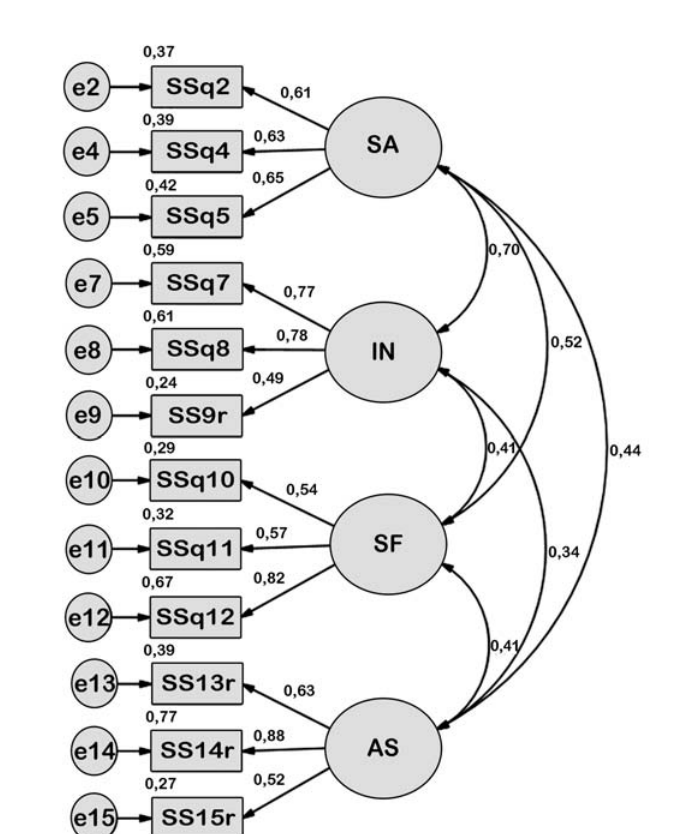
Figura 1 . Pesos fatoriais e con fi abilidade indi- vidual dos itens da ESSS re fi nada e correlações entre fatores na amostra global (Portugal e Bra- sil). Os itens revertidos são identi fi cados com um “r” (  2 / gl =4,534; CFI=0,943; GFI=0,964, TLI=0,922; RMSEA=0,059; IC90% RMSEA